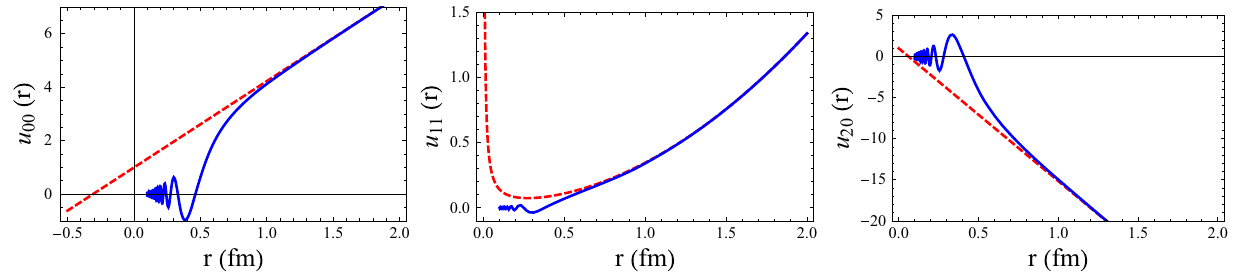
Fig. 2 Zeromomentumintegrated-inwavefunctions(solid)fromlarge I = 0 (left), I = 1 (middle) and I = 2 (right). We also draw the distancesusingthescatteringlengthasinputandthechiral2 π exchange asymptotic zero energy wave function (dashed) for √ s = 2 m π as a function of the distance for potentials V ππ at threshold